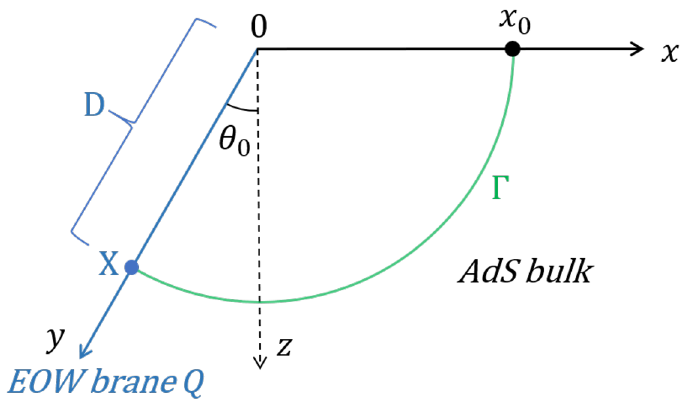
Figure 2. The RT surface Γ for an interval I := [0; x 0 ] that contains the boundary. When the boundary of the BCFT is contained in the interval, Γ will extend to the EOW brane, on which conformal matter is